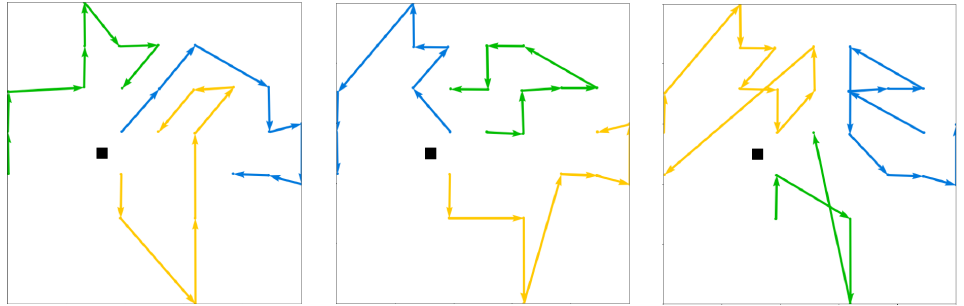
Figure 9. Routes for each path planning method, from left to right: GLOP, GAM, HPP. The black square signifies the launch point. Plotted with tools from [34].